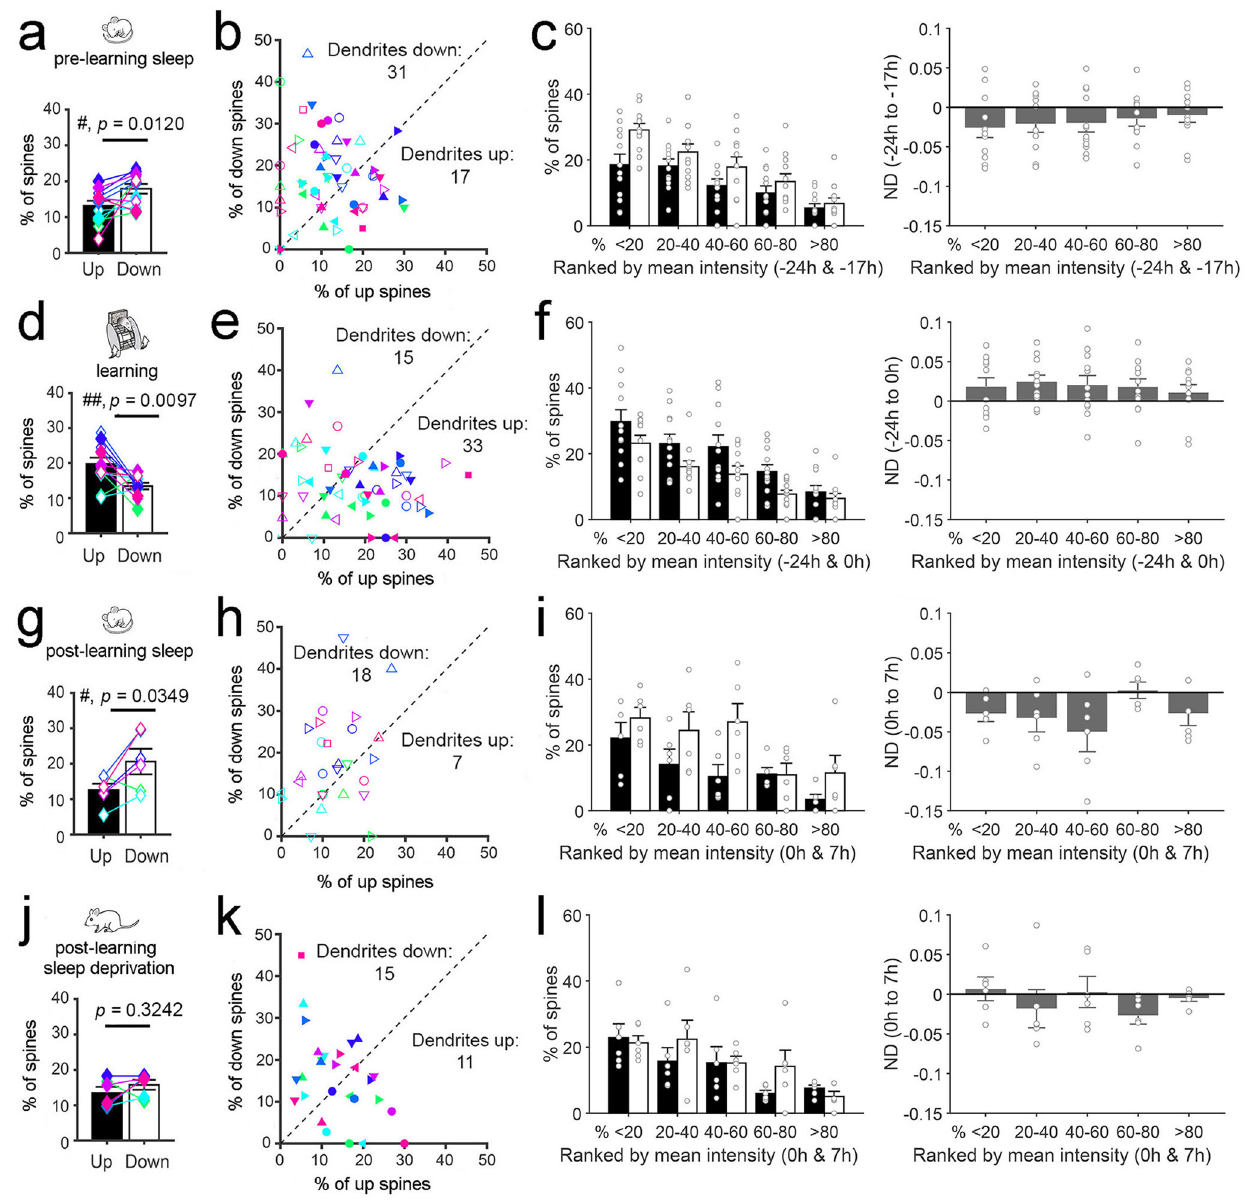
Fig. 3 Single spine analysis of changes in SEP-GluA1 expression after sleep/wake and motor training. a , b Percentage of up (ND > 0.15) and down (ND < − 0.15) spines ( a ) and up and down dendrites ( b ) after pre-learning sleep. In a colored symbols indicate individual animals ( n = 12 mice; mean ± SEM). c Left, percentage of up spines (black bars) and down spines (white bars) in each quintile; right, ND (normalized difference; mean ± SEM) in spine SEP- GluA1 expression in each quintile. Spines were subdivided in quintiles and ranked in strength based on the mean SEP-GluA1 expression of the two time points indicated on the x axis. White circles indicate individual animals ( n = 12 mice). d – f Same as ( a – c ) for motor learning ( n = 12 mice). g – i Same as ( a – c ) for post-learning sleep ( n = 6 mice). j – l Same as ( a – c ) for post-learning sleep deprivation ( n = 6 mice). In a , d , g , j the p values are computed using a two- sided paired sample t test. In b , e , h , k the percentage of up/same/down spines in each dendritic branch is as follows (mean ± std, in %): pre-learning sleep ( − 24 h to − 17 h, all mice): up 12.3 ± 8.16, same 70.3 ± 12.2, down 17.4 ± 9.9; learning ( − 24 h to 0 h, all mice): up 17.9 ± 10.9, same 68.7 ± 11.9, down 13.4 ± 7.62; post-learning sleep (0 h to 7 h, 6 mice): up 12.4 ± 6.7, same 68.7 ± 15.4, down 18.9 ± 12.3; post-learning SD (0 h to 7 h, 6 mice): up 13.8 ± 7.31, same 70.5 ± 9.7, down 15.7 ± 10.4. Source data are provided as a Source data fi despite affecting largely different spines, the overall effect of sleep was the same with or without training.